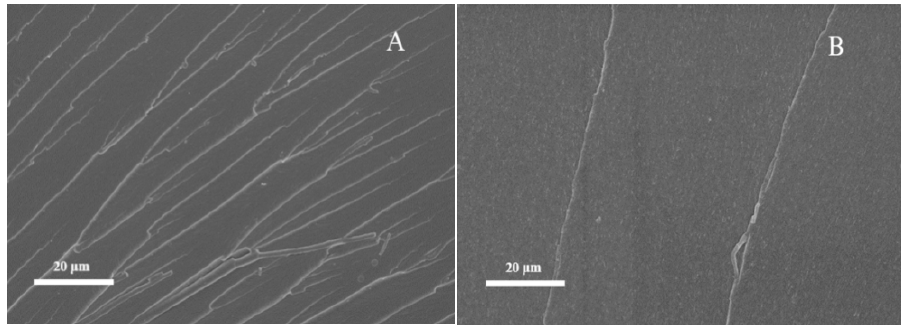
Figure 10. SEM micrographs of the printed the before ( A ) and after post-cured ( B ) samples.